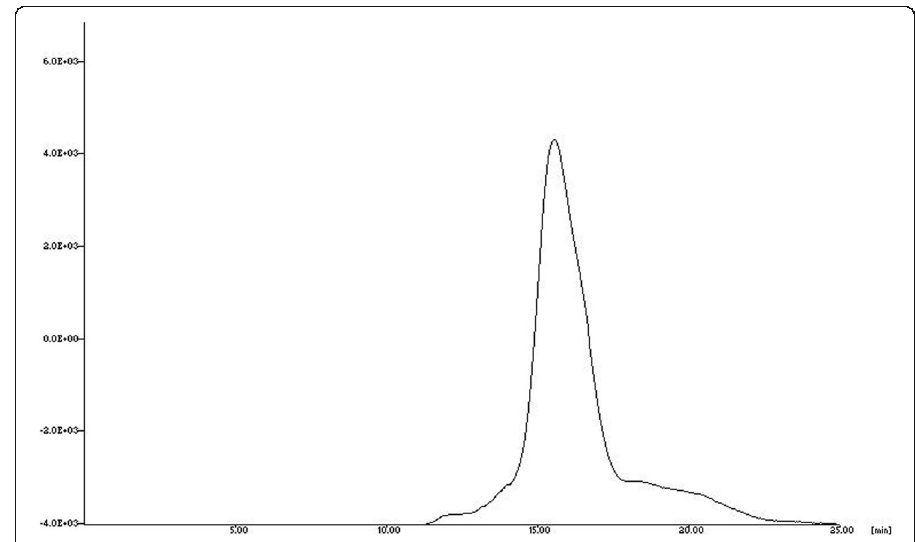
Fig. 3 Radio-HPLC analysis of the urine sample of MUC1-FA-[ 18 F]SFB obtained from the mouse during biodistribution at 60 min post-injection